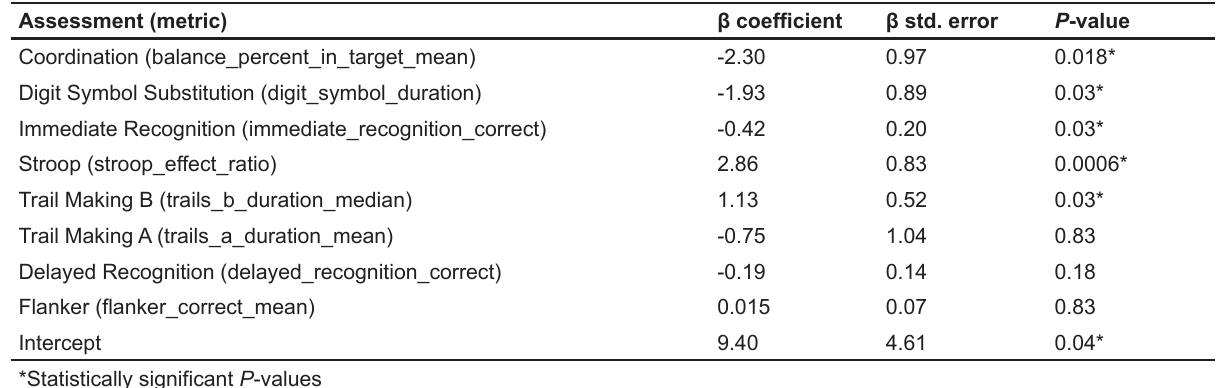
Table 3. Summary of logistic regression results